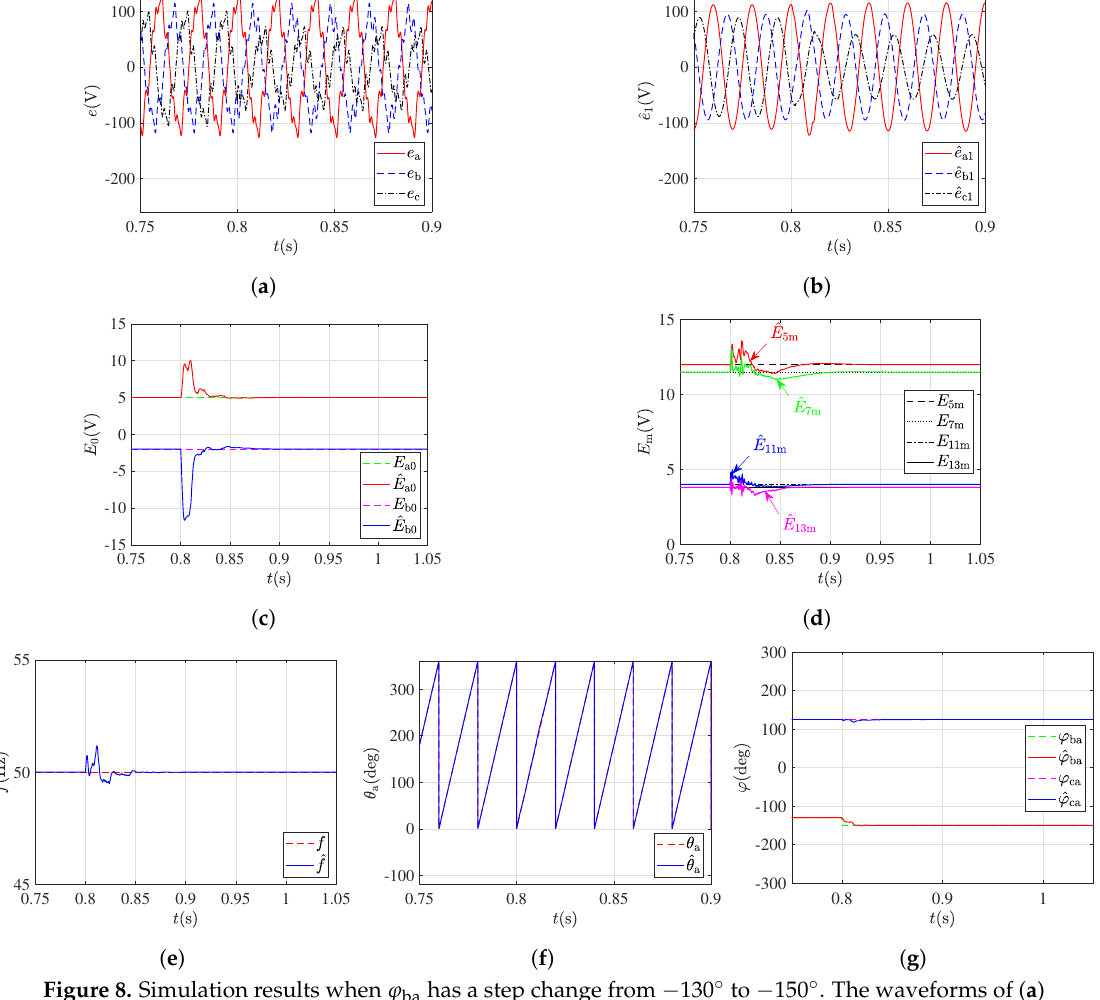
Figure 8. Simulation results when ϕ ba has a step change from − 130 ◦ to − 150 ◦ . The waveforms of ( a ) e abc ; ( b ) ˆ e abc1 . The actual and estimated parameters of ( c ) E a0 , E b0 ; (d) E 5m , E 7m , E 11m , E 13m ; ( e ) f ; ( f ) θ a ; ( g ) ϕ ba , ϕ ca .